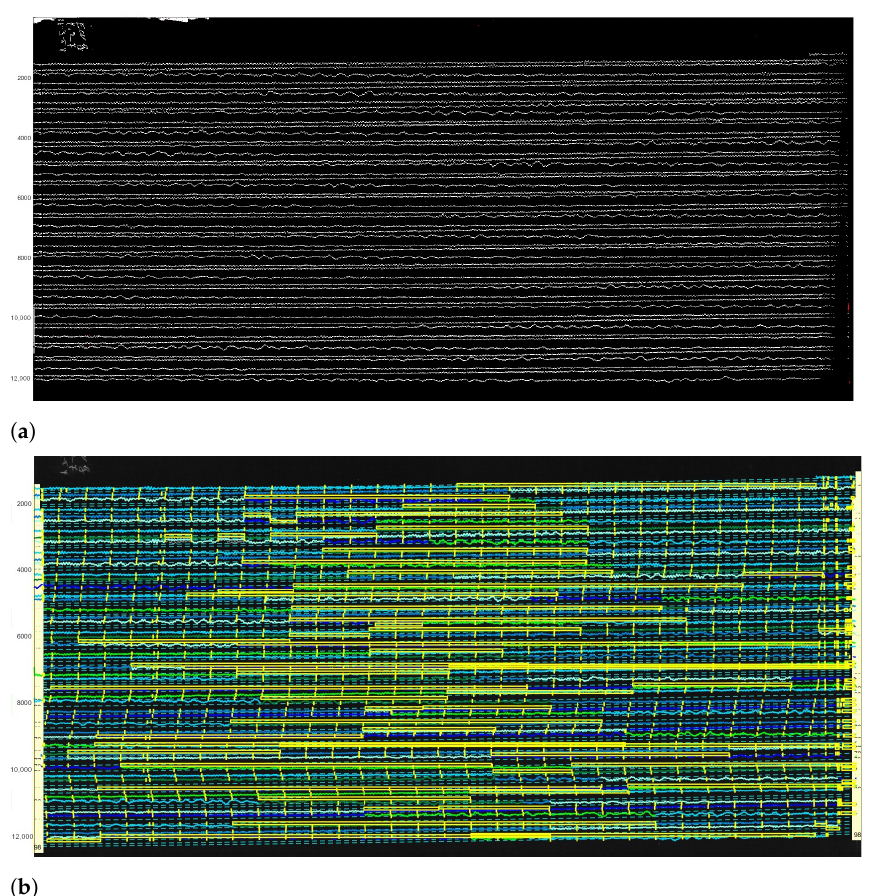
Figure 17. Classified image ( a ) and digitised results ( b ). Here: UCC19540311Gal_E_0727 (11 March 1954). ( a ) Classified image recognised by DigitSeis into ‘traces’ and ‘noise’ (Here: the image UCC19540311Gal_E_0727.TIFF). ( b ) The distinct coloured traces and minute time gaps are visible on a digitised image (Here: the resulted file in a MATLAB format,